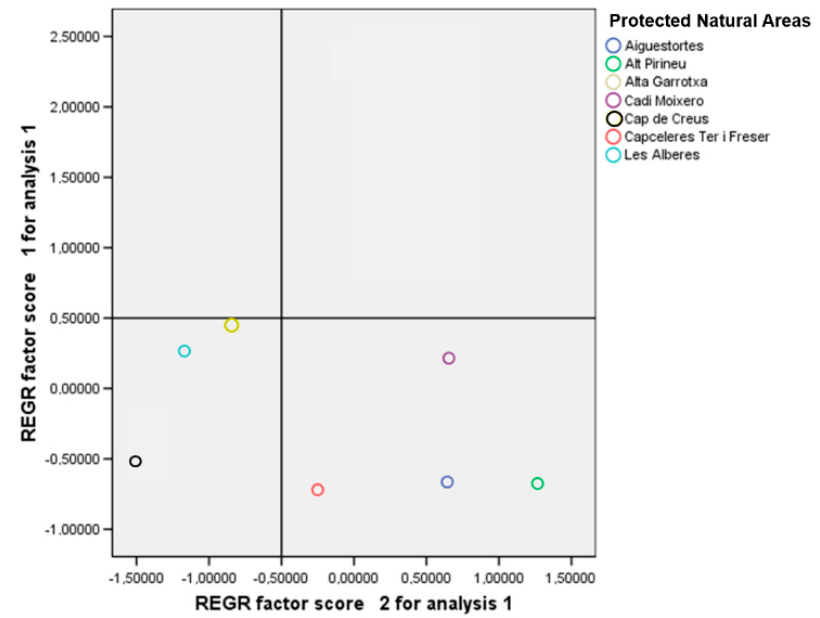
Figure 6. Principal component analysis (PCA) data clustering. Alpine cluster: Aiguestortes National Park, Alt Pirineu Natural Park, Cadi-Moixero Natural Park, Capcaleres del Ter i Freser Protected Area. Mediterranean cluster: Alta Garrotxa Protected Area, Albera Natural Site of National Interest, Cap de Creus Natural Park. Table 3. Configuration analysis for Mediterranean mountain regions. S (patches with an average area of 1 ha), size M (patches with an average area of 5 ha) and size L (patches with an area average of 50 ha). Biogeographic Region